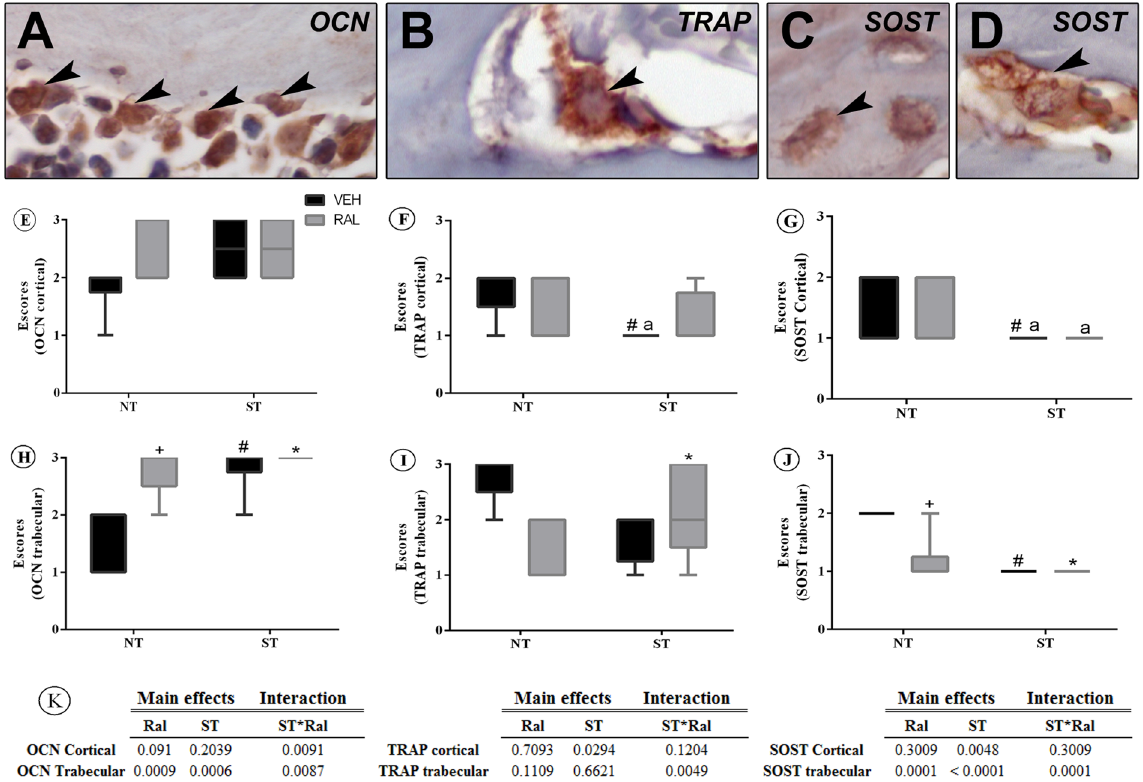
Figure 6. Immunolabeling for OCN, TRAP and SOST assessed by immunohistochemistry. ( A – D ) Photomicrographs showing osteoblasts OCN-positive ( A ), osteoclast TRAP-positive ( B ), osteocytes SOST- positive ( C ) and osteoclast SOST-positive. ( E – J ): Graphs showing the distribution of scores for OCN ( E and H ), TRAP ( F and I ) and SOST ( G and J ) in cortical and trabecular bone in the different experimental groups. ( K ) summary of p values in two way ANOVA analysis, n = 7 animals/group. Statistical analysis was performed with two-way ANOVA, followed by Tukey post-hoc testing ( p < 0.05) to analyze the effect of strength training (ST) and raloxifene (Ral) treatment, and any interactions (ST * Ral). Abbreviations and symbols: + main effect of Ral, #main effect of ST, * interaction of ST plus Ral a , vs NT-Veh; b vs NT-Ral; c vs ST-Veh. OCN = osteocalcin, TRAP = tartrate-resistant acid phosphatase and SOST = sclerostin. NT-Veh = non-trained and treated with vehicle; NT-Ral = non-trained and treated with raloxifene; ST-Veh = strength training and treated with vehicle; ST-Ral = strength training and treated with